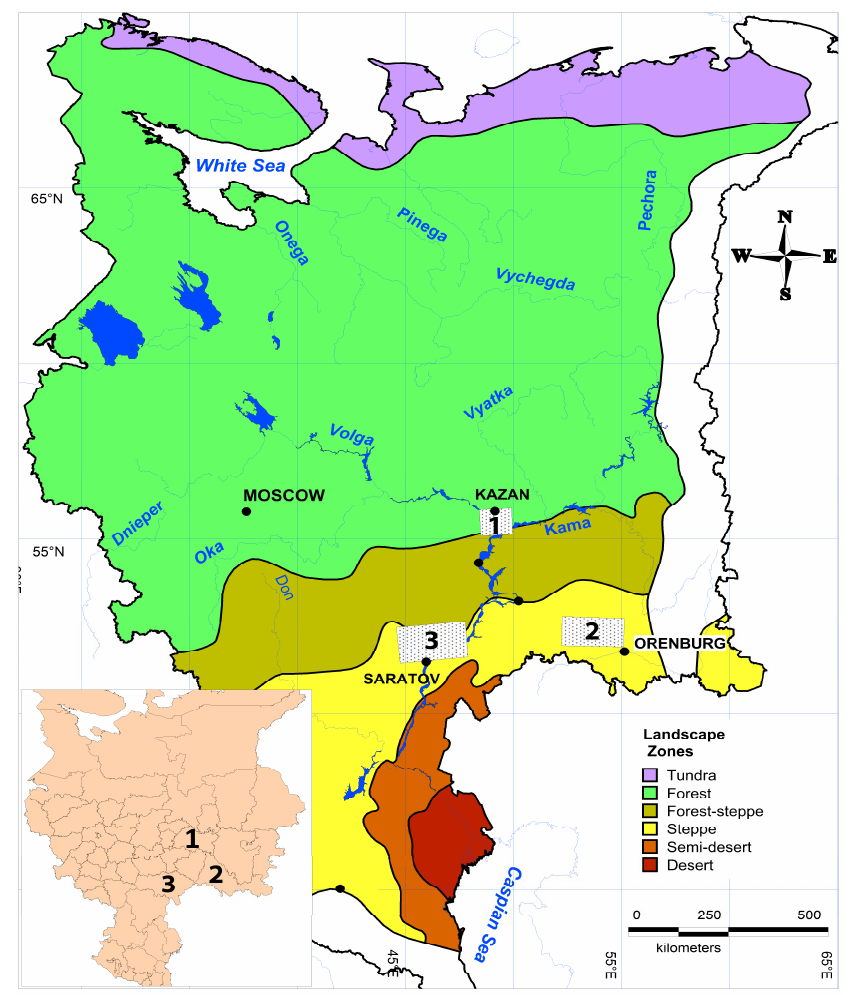
Figure 4. The layout of the areas to study the dynamics of ephemeral gully erosion (1—key areas in the Mesh river basin, No. 1–7; 2—key areas in the Samara river basin, No. 8–22; 3—key areas of the Medveditsa basin, No. 23–32).